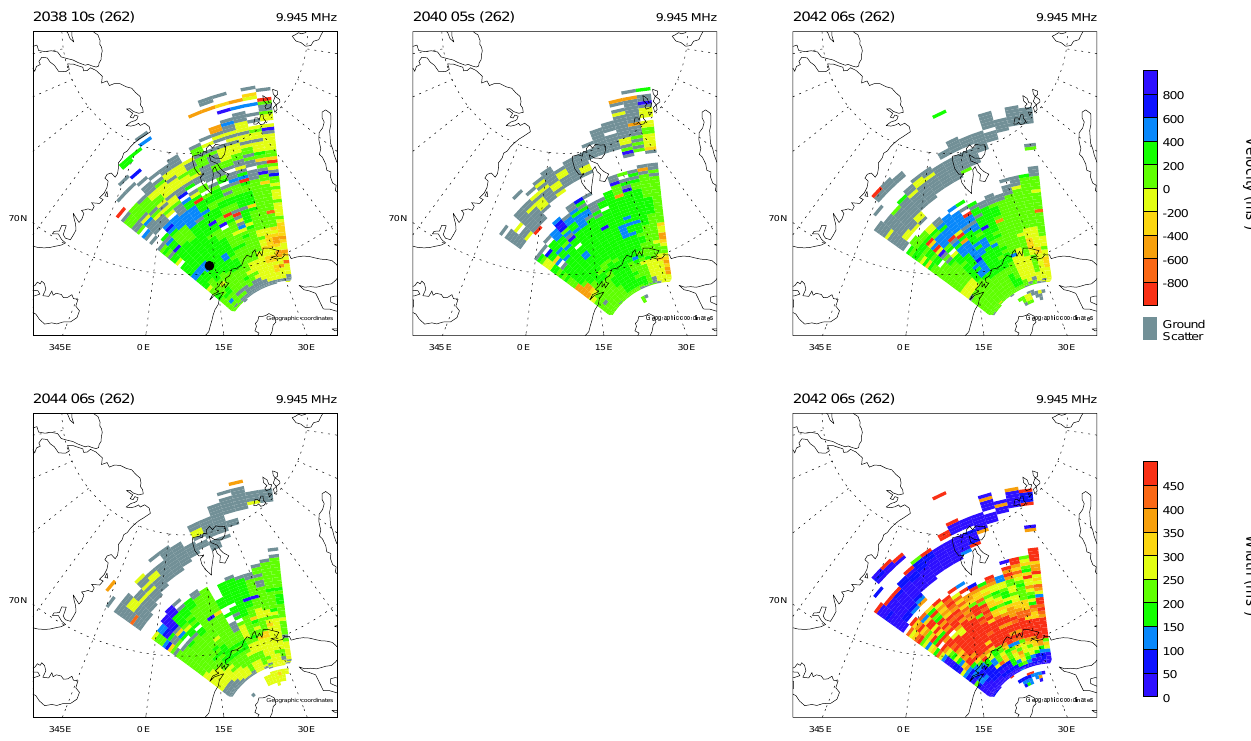
Fig. 9. Line-of-sight plasma velocities (all plots in the top row and the first plot in the bottom row) and back scatter spectral width (second plot in the bottom row) as observed by the Finnish CUTLASS radar. The green-blue (yellow-red) colors mark velocities toward (away from) the radar in the velocity plots and small (large) widths in the spectral width